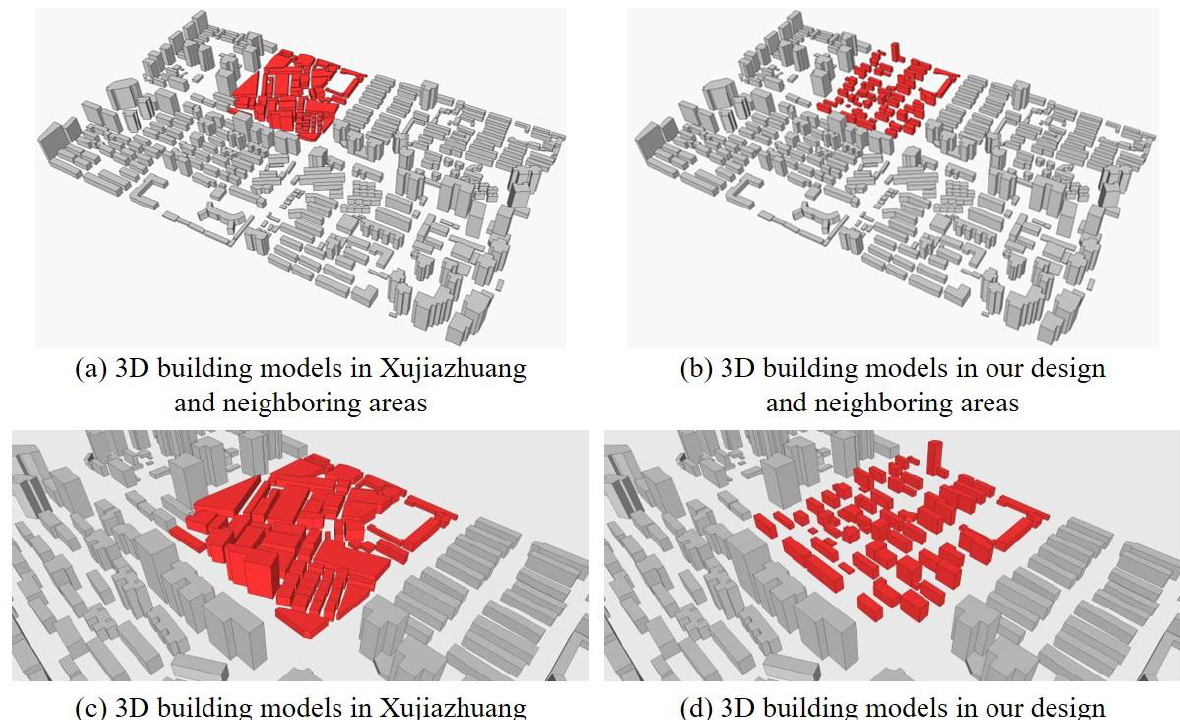
Figure 8. Three-dimensional (3D) building models in Xujiazhuang and our design.